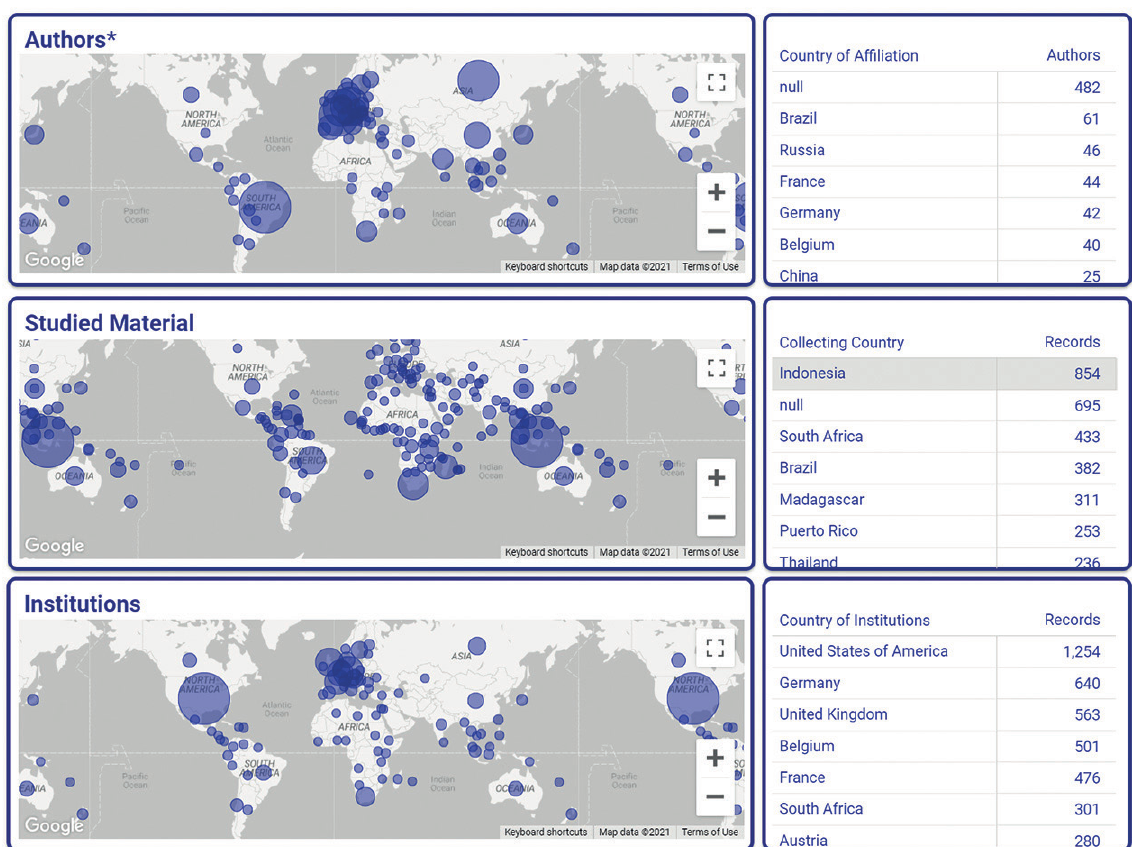
Fig. 8. Comparison of the location of the study author, the origin of the studied material and the institution or collection where the holotype specimen referenced in the material citation is